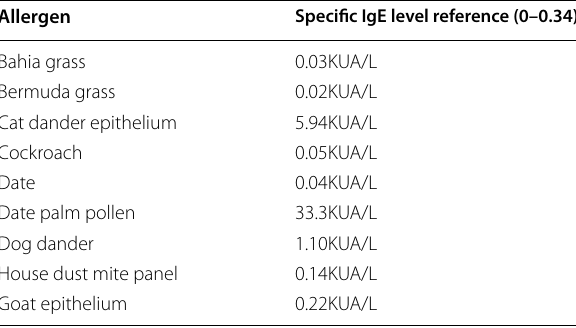
Table 1 Results of specific IgE